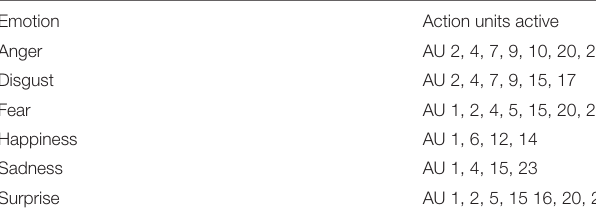
TABLE 2 | Action units involved to express basic